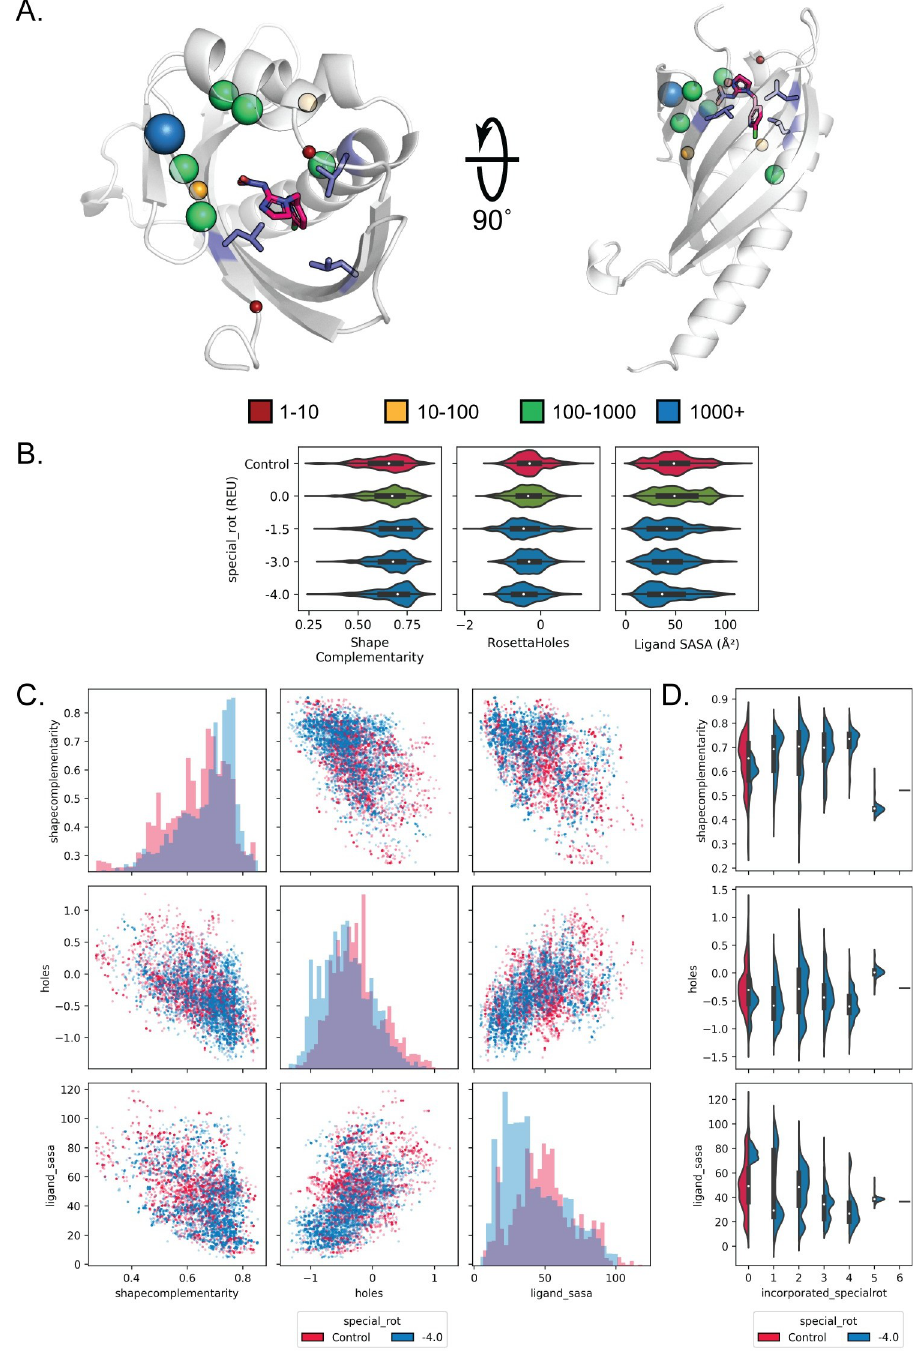
Fig 7. Composite binding sites combined with complementary rotamers improve design quality metrics for (E)- imidacloprid. A. Spheres indicate the number of complementary rotamers accepted per position to design the context of an all-leucine composite binding site (purple) for (E)-imidacloprid (hot pink) placed into the scaffold protein PDBID 1JKG. B. Plots and design metrics are as in Fig 6. Application of complementary rotamers improve shape complementarity and ligand SASA with increased special_rot bonus. C. Plots and design metrics are as in Fig 6. Designs show simultaneous improvement in shape complementarity, ligand SASA, and binding site packing with the application of complementary rotamers. D. Violin plots showing the distributions of each design metric as a function of incorporated complementary rotamers.